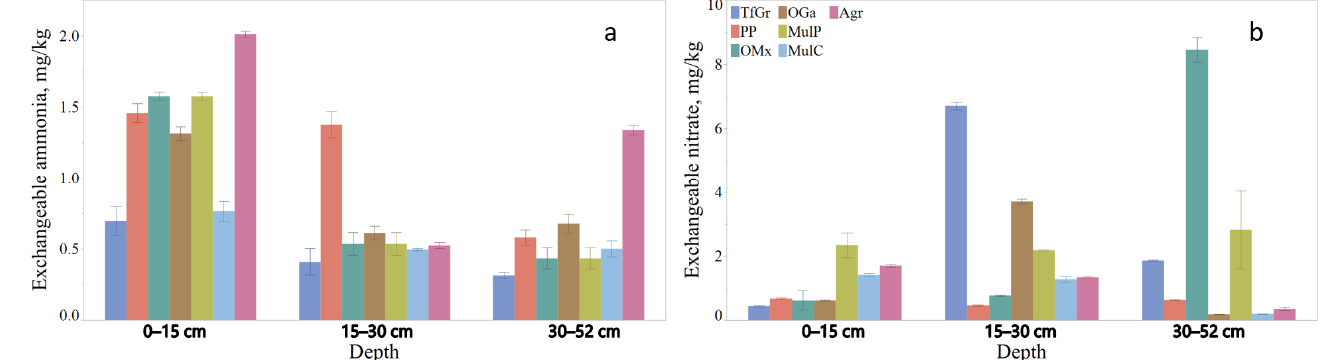
Figure 4. Exchangeable soil ammonium ( a ) and nitrate ( b ) in each landscape patch by soil depth. Agr; remnant agricultural field, TfGr; turfgrass, PP; perennial peanut, OMx; patch with a mixture of ornamental grasses, OGa; patches with gamma grass, MulP; patch with pine needle mulch, MulC; patch with pine bark nuggets.